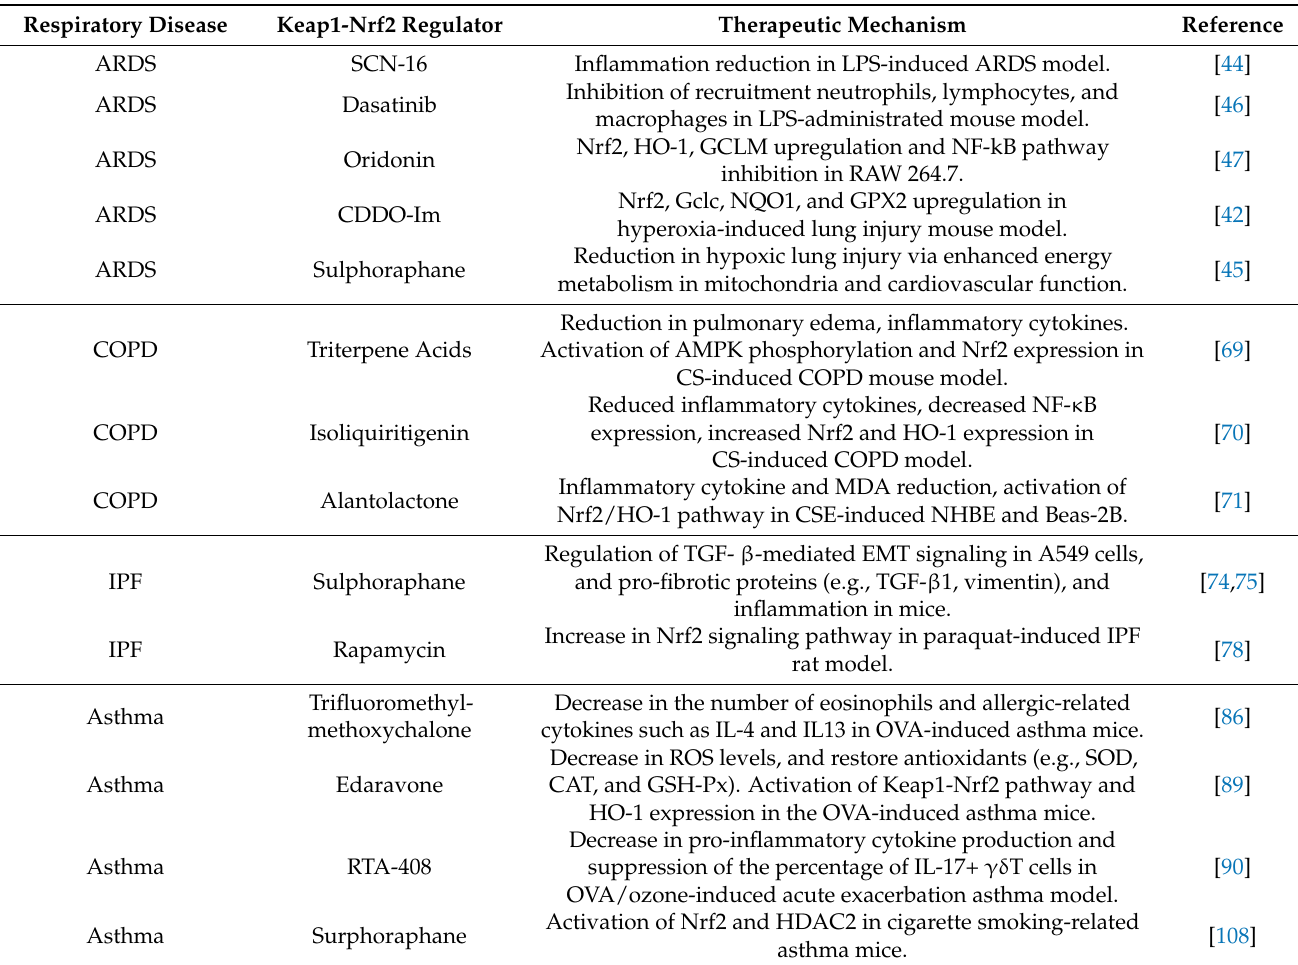
Table 1. Keap1-Nrf2 regulation in respiratory